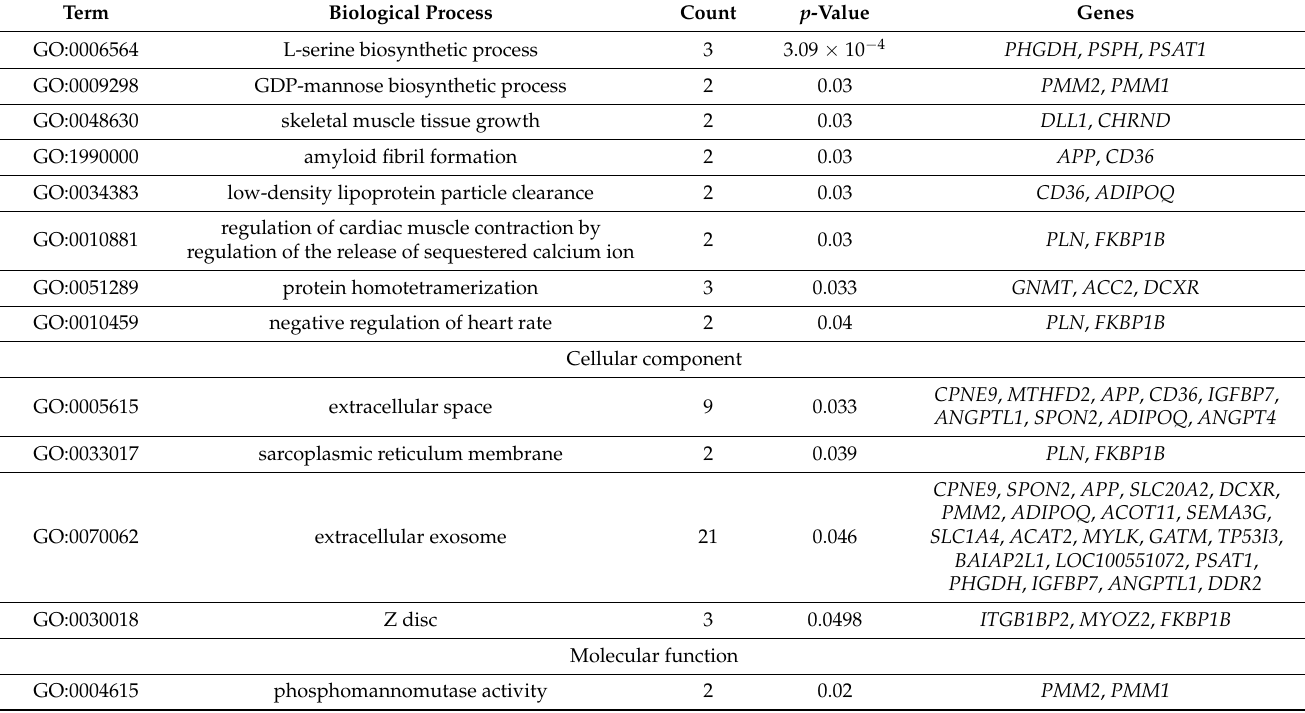
Table 4. Ontology analysis of up-regulated genes in HFE compared to LFE